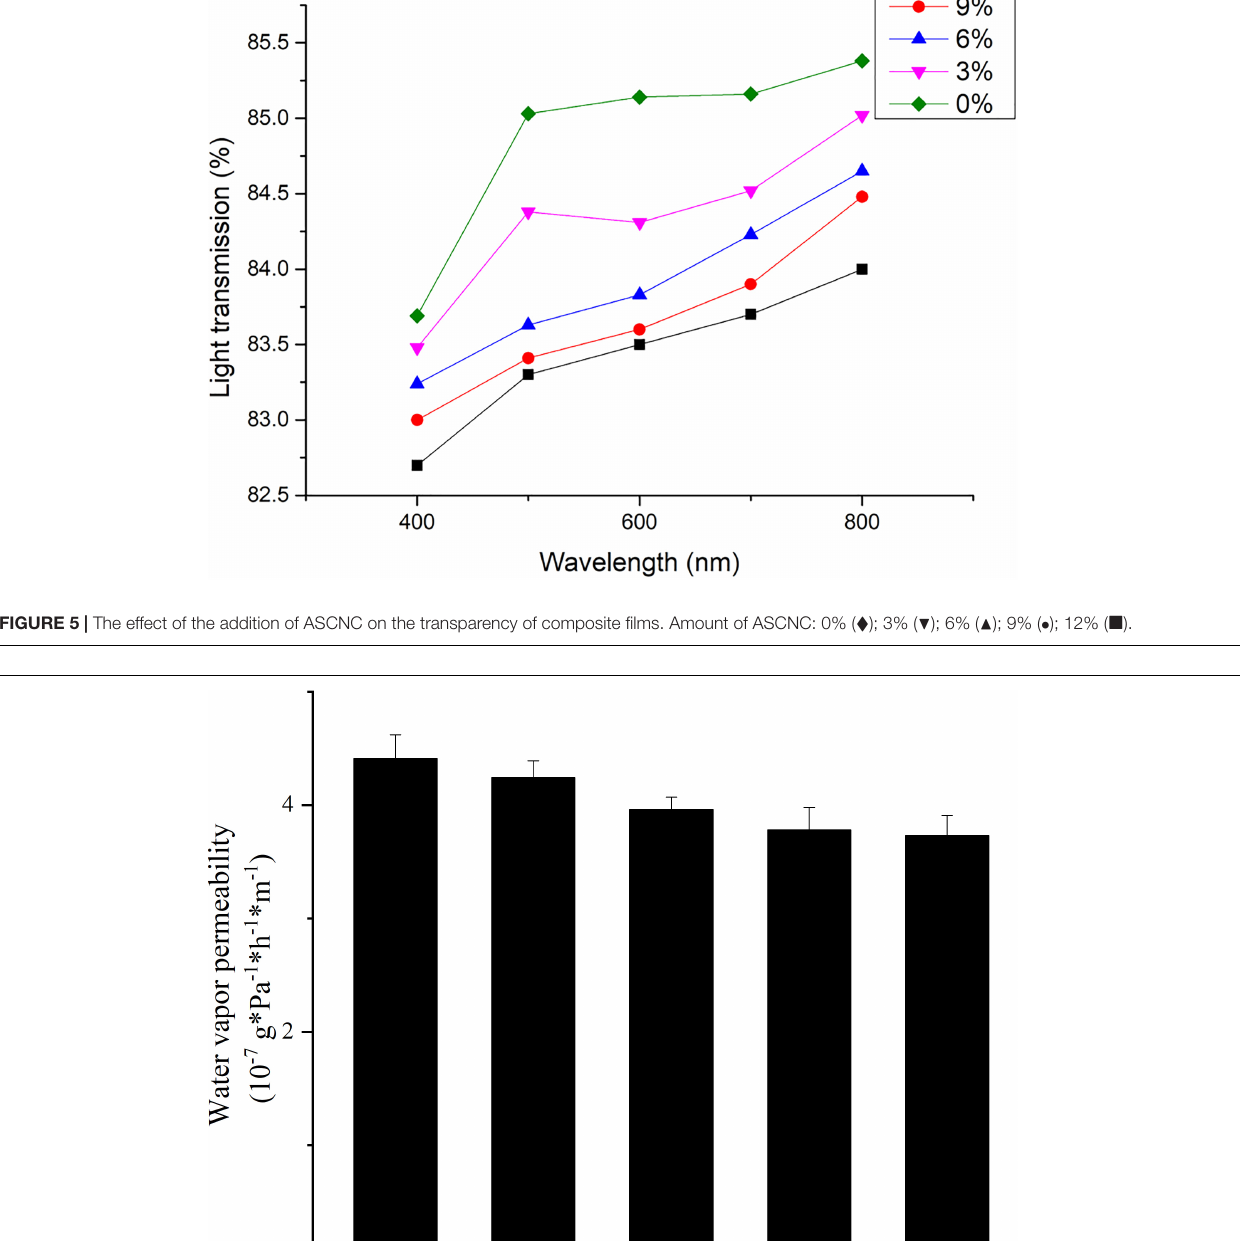
hydrogen bonding property of CNC that created a tendency to aggregate (Fortunati et al., 2013). In contrast to results of the tensile strength, the elongation at break of the composite